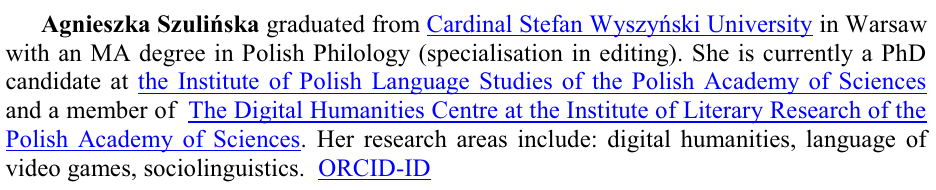
Figure 4: SSHOC Announcement selection of SSH Open Marketplace